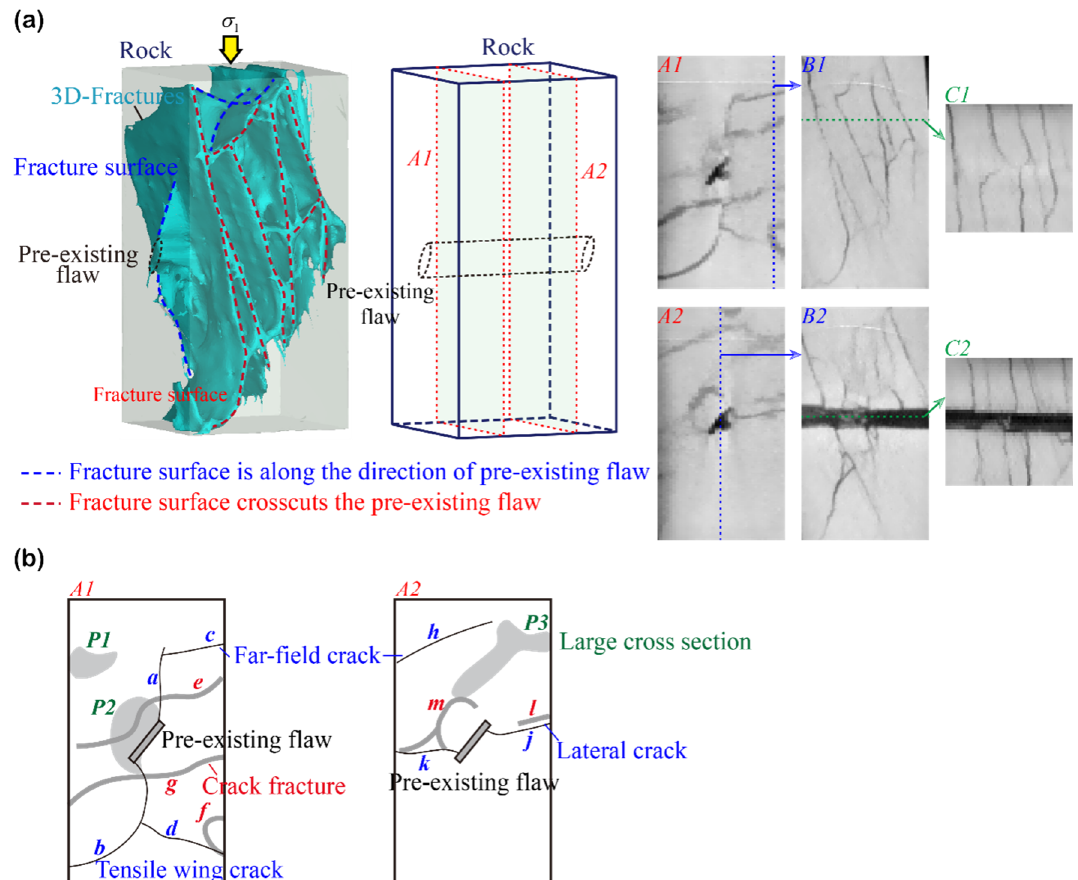
Figure 5. ( a ) Distribution of internal fissures in rocks with prefabricated fissures under UT; ( b ) Var- ious crack types from single fissure identified.